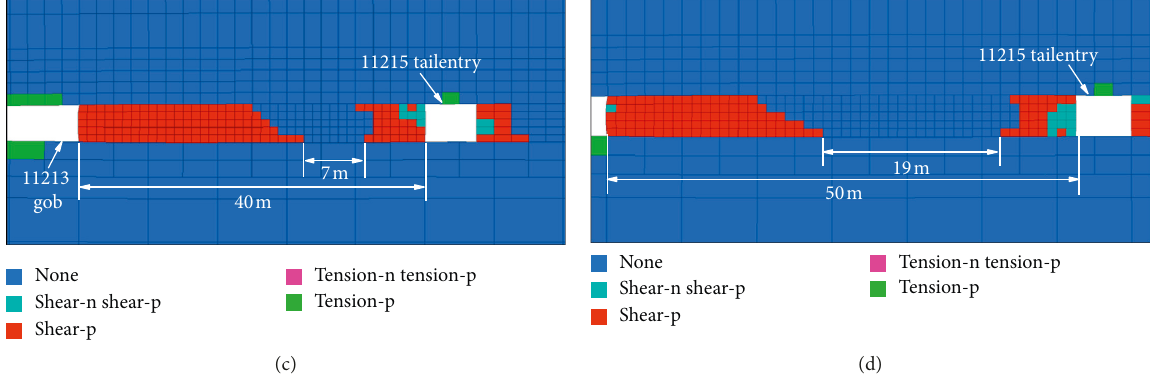
Figure 18: Distribution of the damaged zone in variable width chain pillars. (a) Width of the chain pillar was 20m. (b) Width of the chain pillar was 30 m. (c) Width of the chain pillar was 40m. (d) Width of the chain pillar was